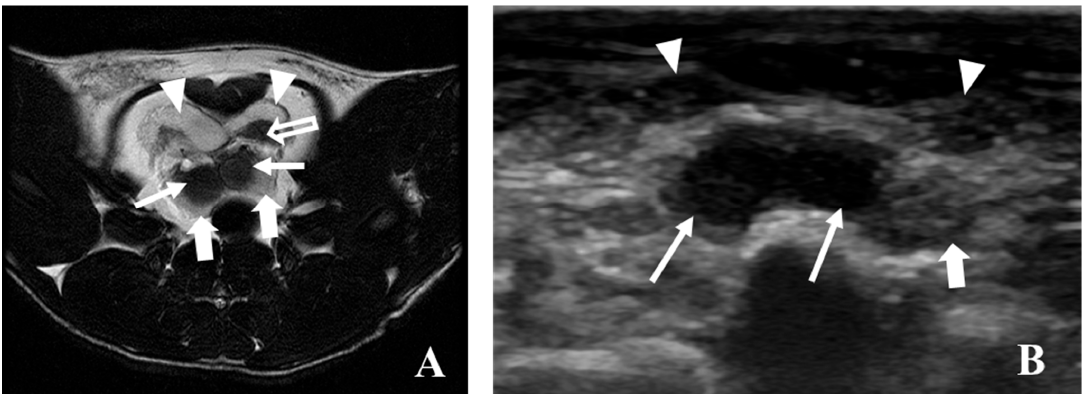
Figure 10. Comparison of an MRI T2 WI ( A ) and ultrasonographic ( B ) transverse scan of the rat prostate. In both images, it is possible to observe the ventral prostate (arrowheads) and the transition